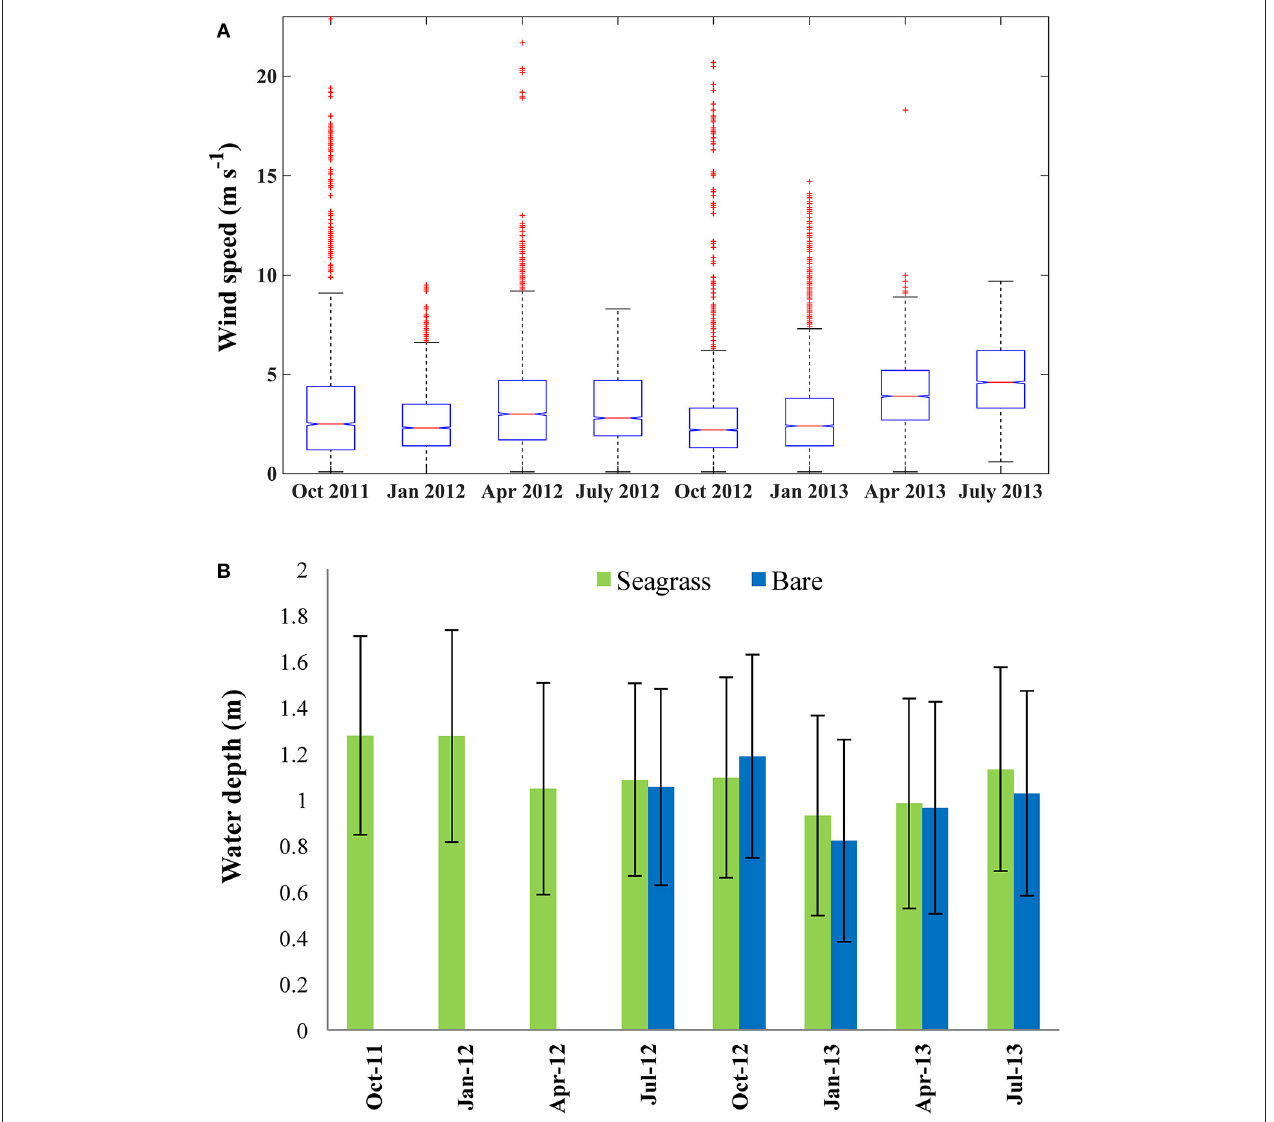
FIGURE 2 | (A) Wind speed measured at the Wachapreague NOAA Meteorological station for each sampling period. Horizontal red line within the box indicates median wind speed, lower and upper edges of the box represent the 25th and 75th percentiles respectively. Red crosses represent outliers. (B) Water depth at the bare (blue) and center seagrass (green) sites averaged across each sampling period. Error bars indicate